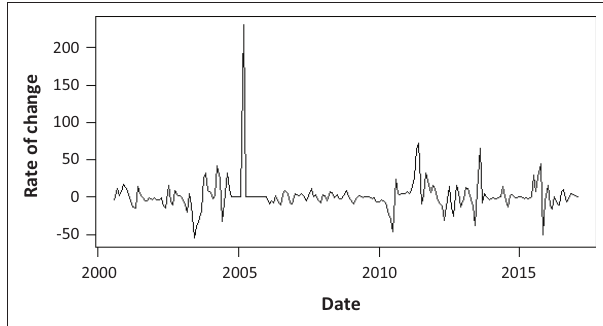
FIGURE 13: Kenya – Movement of the rate of change of monthly interest rates.